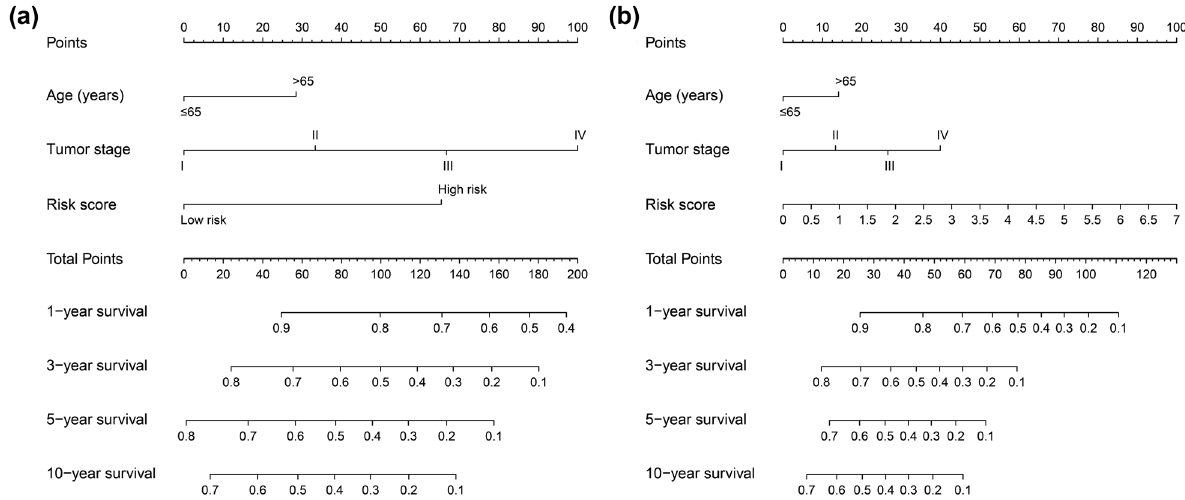
Figure 4: Nomogram for risk score in GC OS: ( a ) nomogram for low - and high - risk score phenotypes in GC OS; ( b ) nomogram for risk score in GC OS.